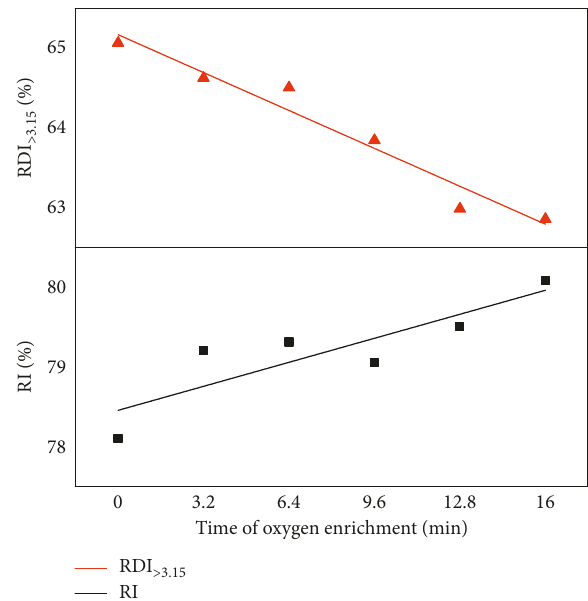
Figure 4: Reductivity and reduction pulverability of the sintered ore for different sintering oxygen enriched